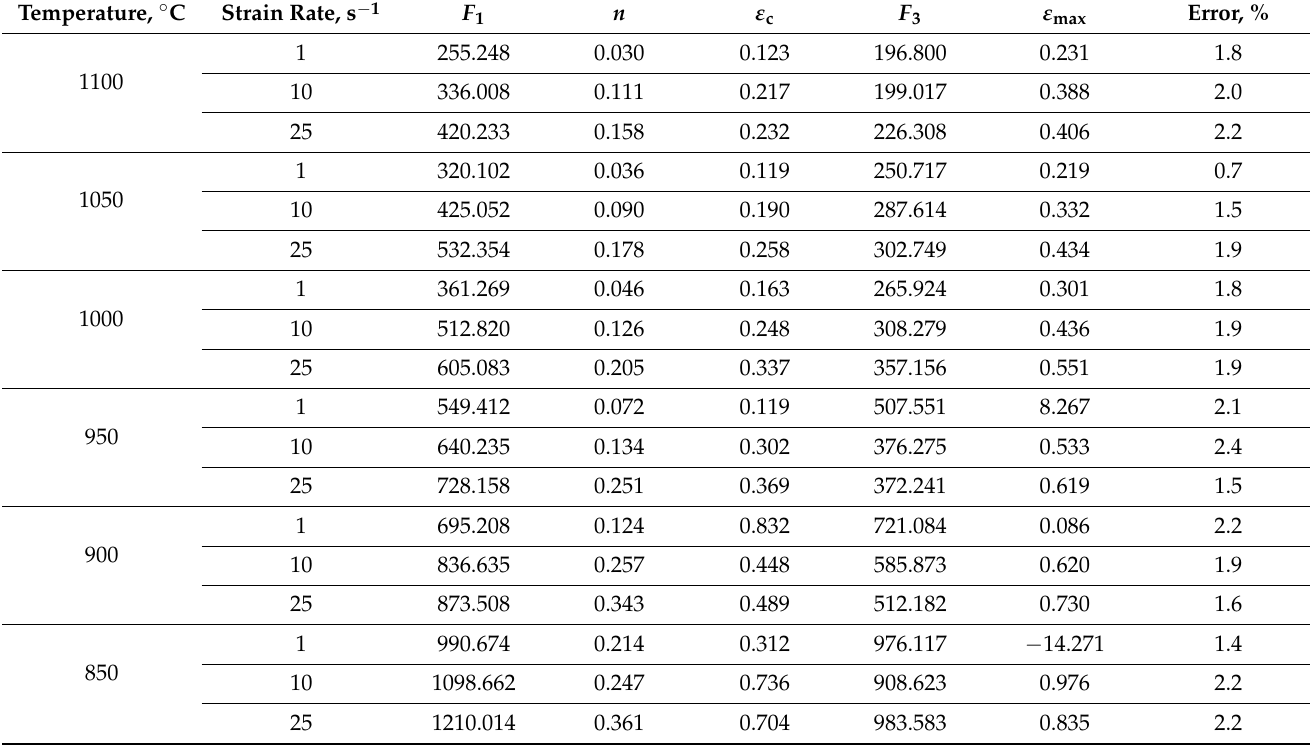
Table 2. Parameters for flow stress determined by inverse